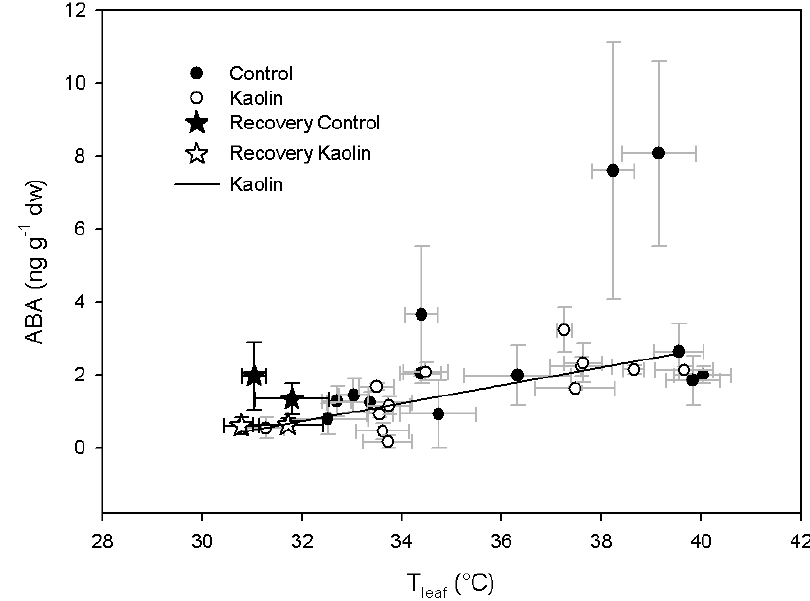
Figure 6. Correlation between leaf abscisic acid (ABA) content and leaf temperature (T leaf ).